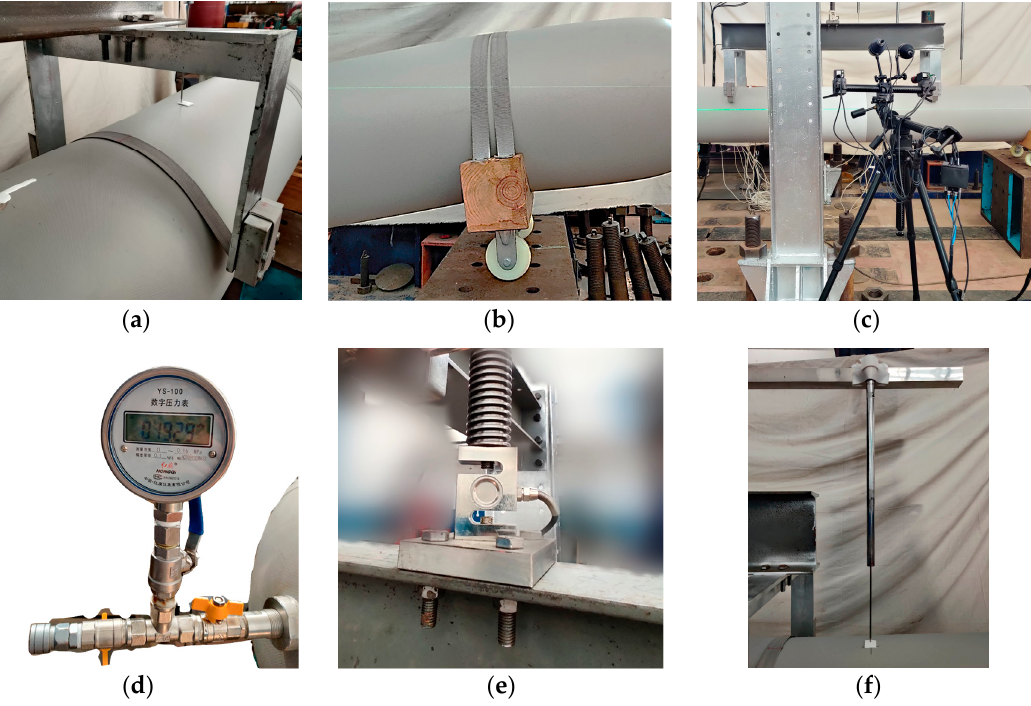
Figure 4. Four-points bend test setup configuration: ( a ) loading frame; ( b ) roller support; ( c ) Digital Image Correlation measure system; ( d ) air pressure gauge; ( e ) s-type load cell; ( f ) LVDT.